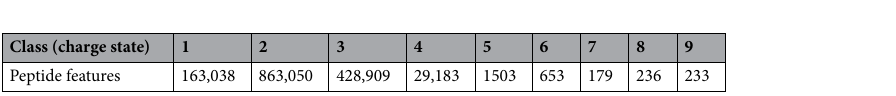
Figure 8. ( a ) An area in LC-MS map is shown. A target window in bold black rectangle containing a feature in blue color is shown. This target window and its four surrounding regions (as shown in Fig. 4b) forms a positive training sample for IsoDetecting module. We also slide the target window within the region showed by arrow signs to generate training samples holding the peptide feature in different locations of the target widow (some are shown by dotted rectangles). ( b ) One negative training sample containing feature like noises is shown the topmost rectangle. In this region of LC-MS map the traces look like a feature having three isotopes. However, those are actually noisy signals as shown in the middle rectangle. And if we do not provide such training samples, then PointIso label the respective datapoints as positive class and report it as a feature, as shown in bottom rectangle. That is why we should provide such samples during training. ( c ) Some region in LC-MS map containing only arbitrary noises is selected for generating negative training samples. ( d ) Some region in LC-MS map containing blank area is also selected for generating negative training samples.